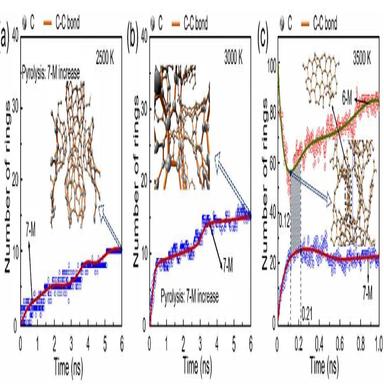
Changes in the number of carbon rings during the conversion of C70 crystals at 2500 K (a), 3000 K (b) and 3500 K (c). The arrow points to the snapshot of the structure at critical points. (A colour version of this figure can be viewed online.)